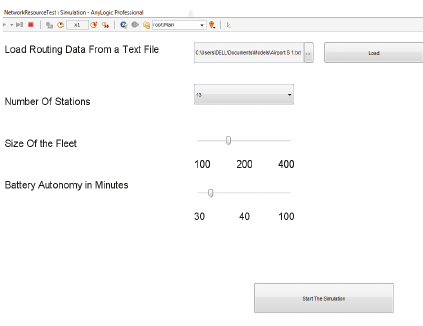
Figure 9: Data inputs of the